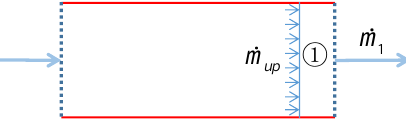
Figure 7. Calculation schematic of boundary nodes.